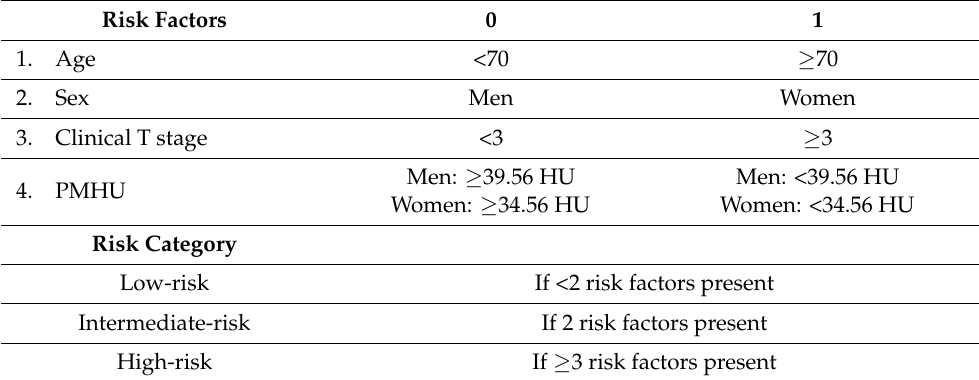
Table 3. Risk factors and risk